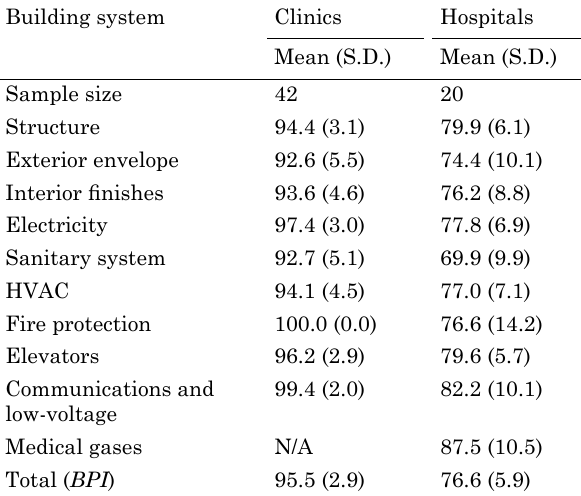
Table 2. Performance scores of building systems in